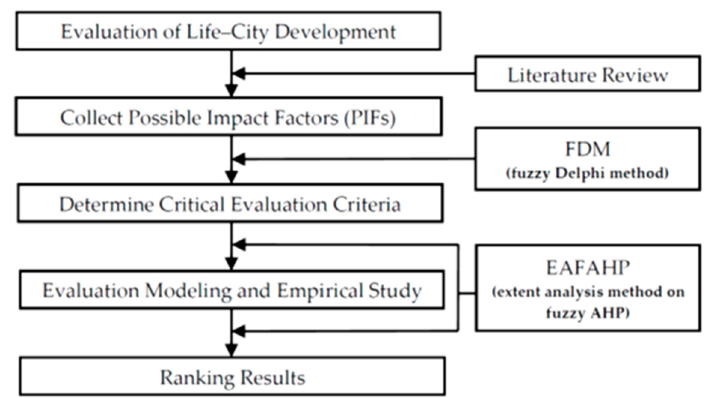
Figure 1. The overall research process.